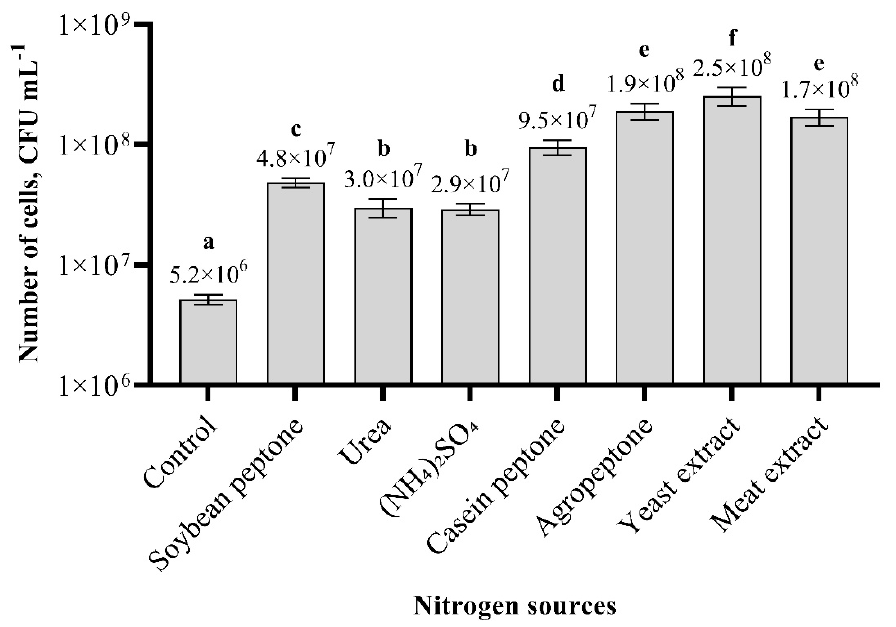
Figure 3. Effect of different nitrogen sources on Paenibacillus sp. MVY-024 biomass production. The values marked with the same letter have no significant difference at p ≤ 0.05.